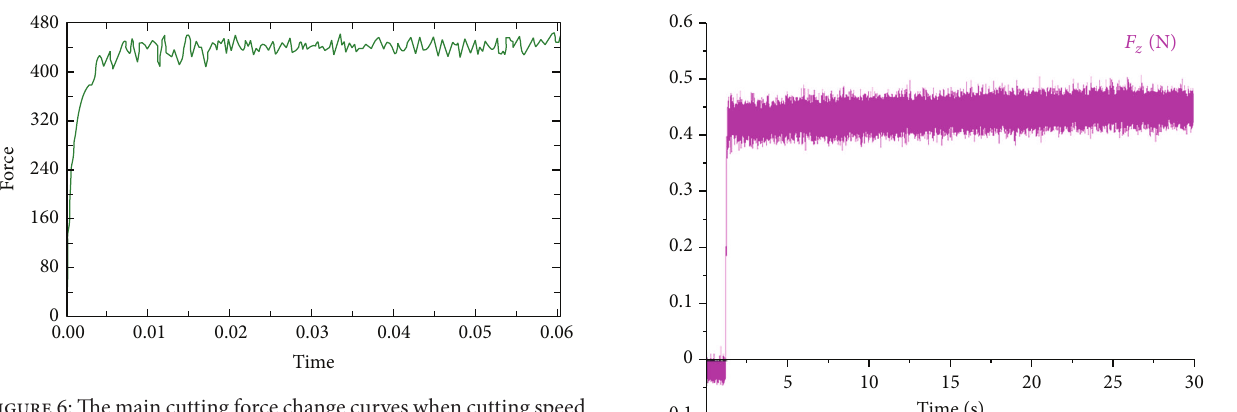
Figure 6: The main cutting force change curves when cutting speed is 254 m/min.